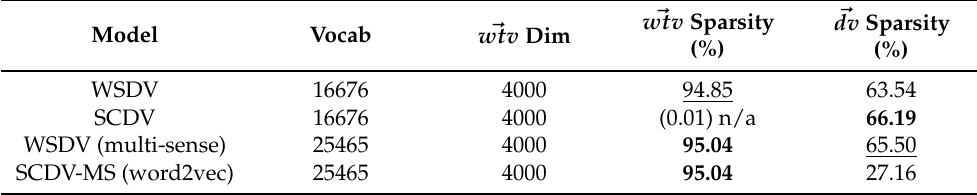
Table 5. Document Sparsity analysis using the 20Newsgroup dataset (20 clusters).